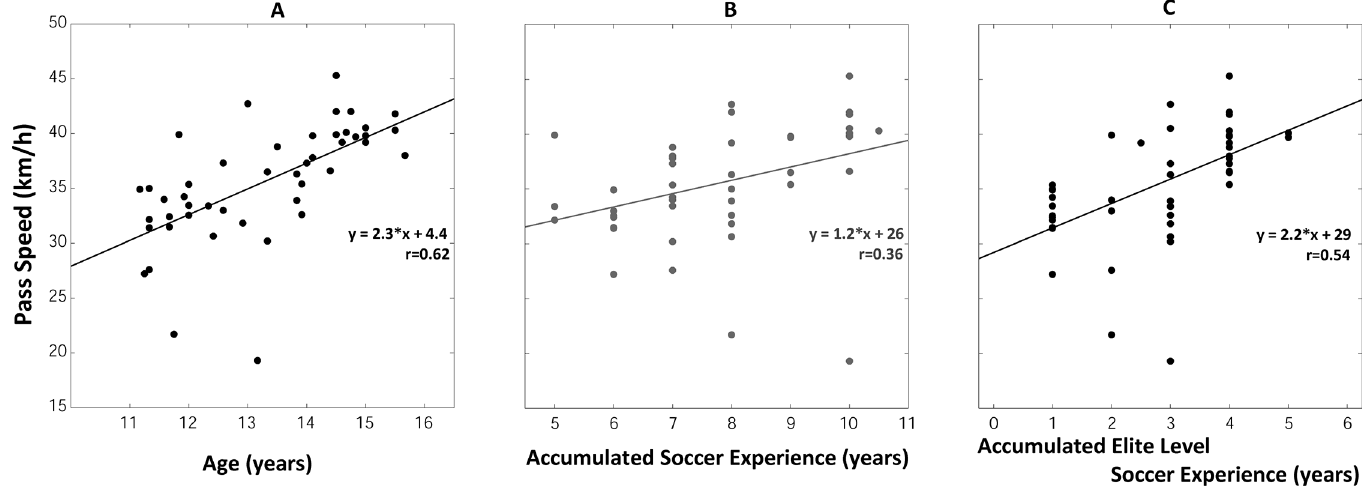
Fig 3. Passing speed of elite young soccer players as a function of age (A), accumulated soccer experience (B) and elite level-soccer experience (C).